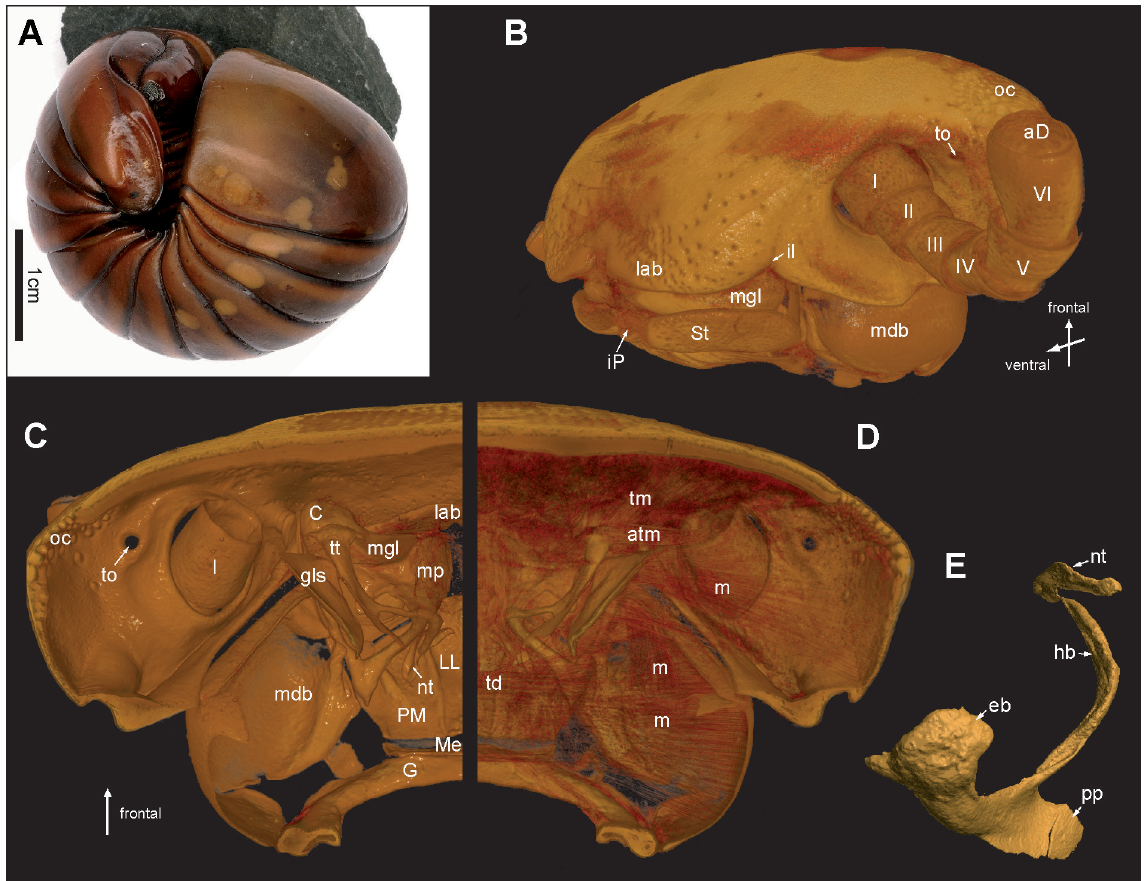
Fig. 1. Sphaeromimus kalambatritra sp. nov. A . Lateral view. B–D . Volume rendering of head based on µCT-images, female paratype (CASENT 9058301). B . Head, outer fronto lateral view. C . Head, inner posterior view of sclerotized structures only. D . Head, inner posterior view of sclerotized structures and soft structures. E . Segmentation of the left tentorium and nebententorium, frontal view. Abbreviations: aD = antennal disc; atm = antennal muscle; C = condylus of mandible gnathal lobe; eb = epipharyngeal bar; G = gula; gls = gnathal lobe sclerite; hb = hypopharyngeal bar; il = incisura lateralis; iP = inner palpi; lab = labium; LL = lamella lingualis; m = mandibular muscle; mdb = mandibular base; Me = mentum; mgl = mandible gnathal lobe; mp = molar plate; nt = nebententorium; oc = ocelli; PM = paramentum; pp = posterior process; St = stipes of gnathochilarium; td = tendon; tm = tentorial muscle; to = Tömösváry organ; tt = tentorium; I–VI =